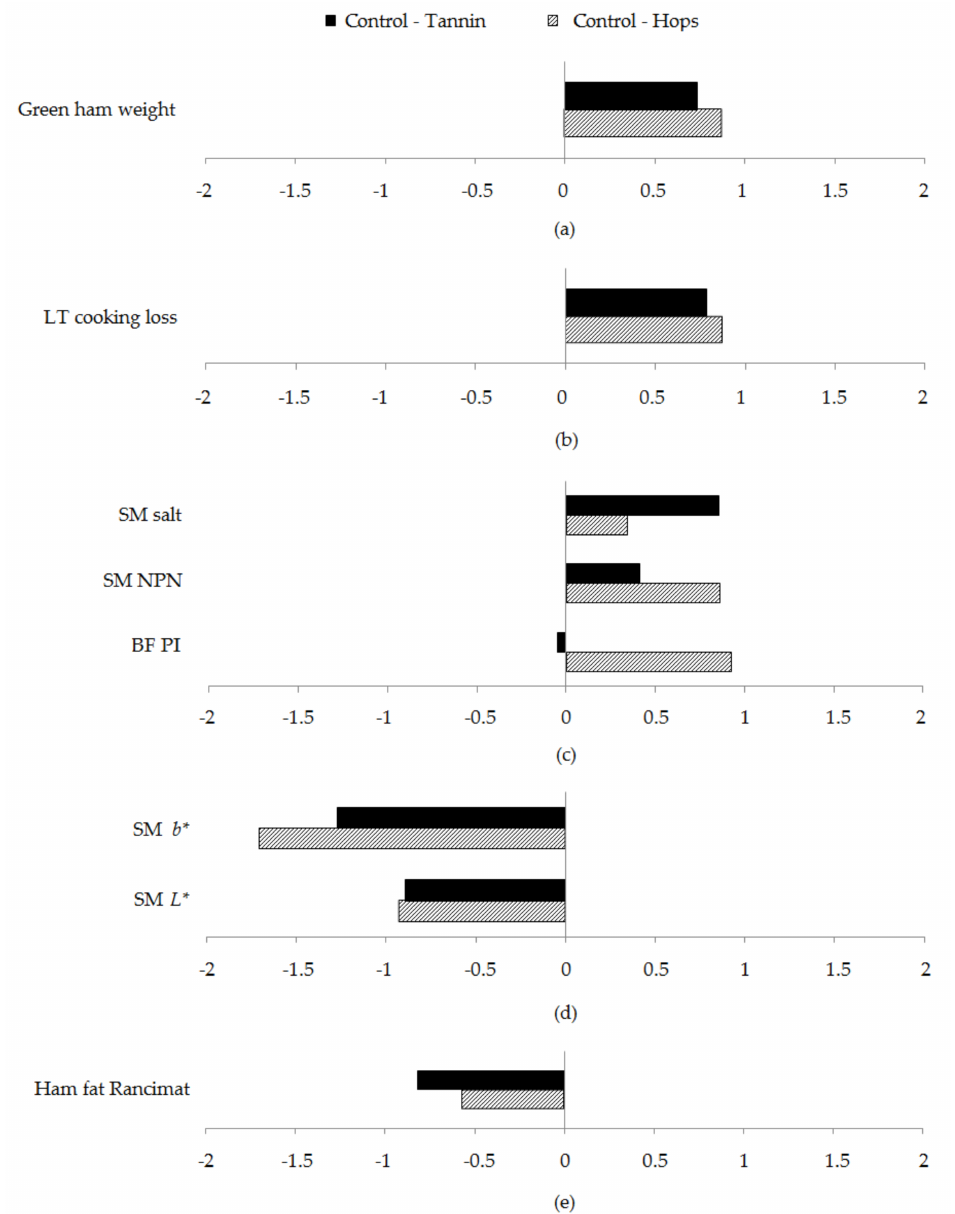
Figure 1. Large e ff ect sizes (Hedge’s g > 0.8) of carcass traits ( a ), water holding capacity ( b ), chemical composition ( c ), color ( d ), and oxidative stability ( e ) denominating the strength of 0.4% hops (Hops) or 3% sweet chestnut wood extract (Tannin) supplementation (LT: Longissimus dorsi ; SM: Semimembranosus ; NPN: Non-protein nitrogen; BF: Biceps femoris ; PI: Proteolysis index; b *: CIE yellowness; L *: CIE